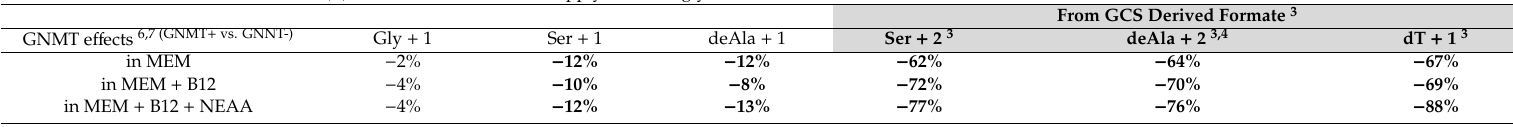
Table 2. Incorporation of [2- 13 C]glycine in serine, dTMP, and methionine via glycine cleavage system. Gly +